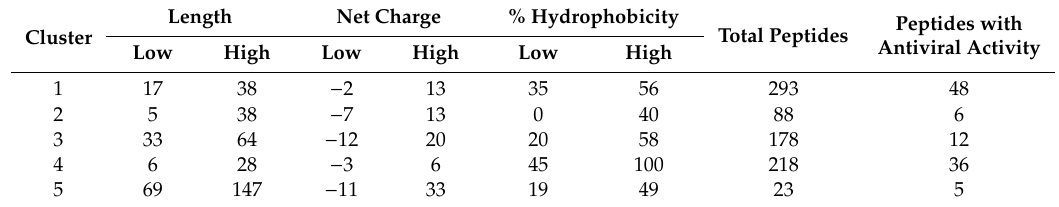
Table 1. Clusters of AMPs found from APD3 Peptide